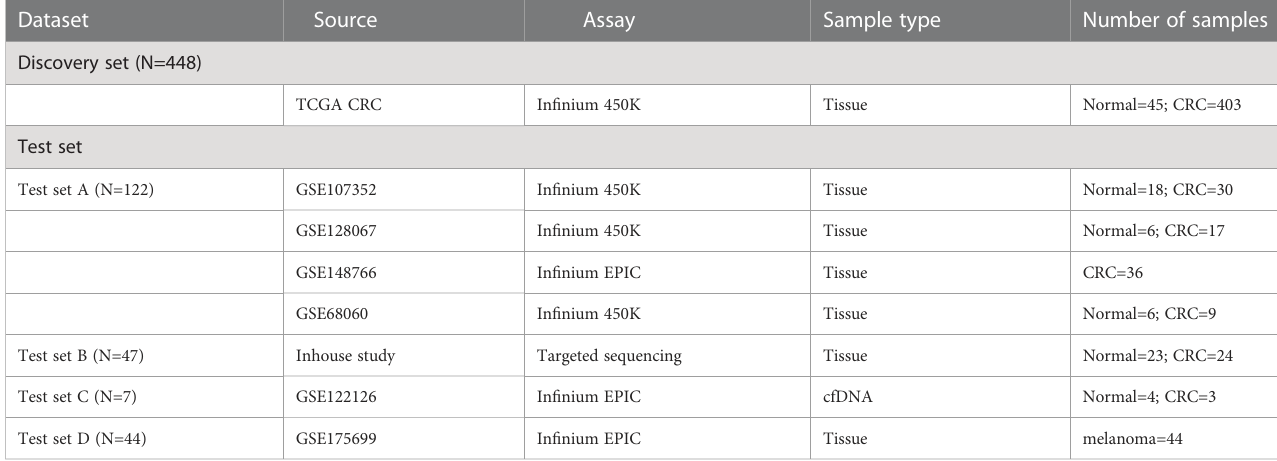
TABLE 1 Overview of the datasets used in this